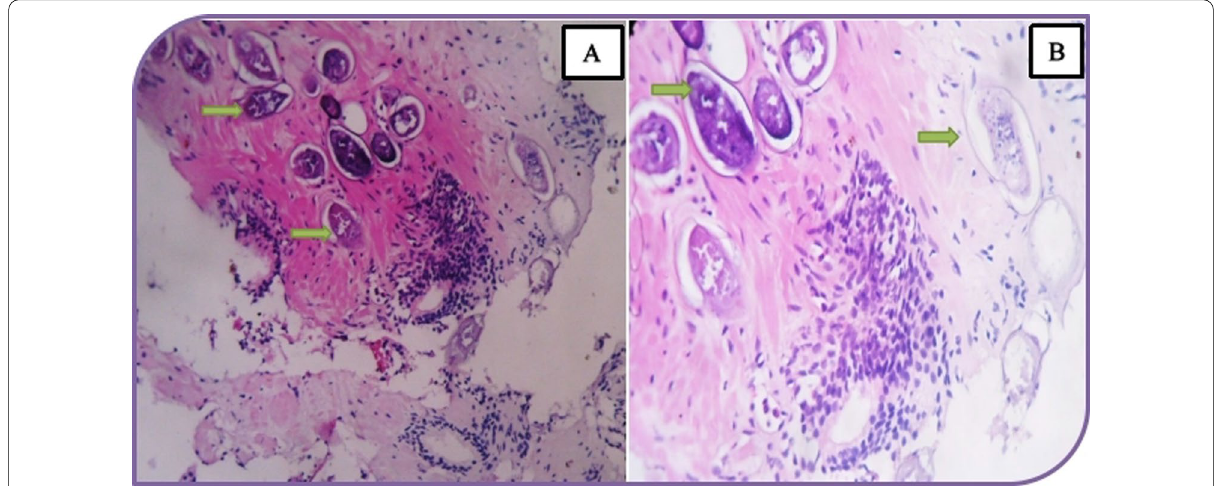
Fig. 2 Nodular hyperplasia of the prostate with Schistosoma ova (green arrow) in myofibrous stroma. a . H & E X 200 while b H & E X